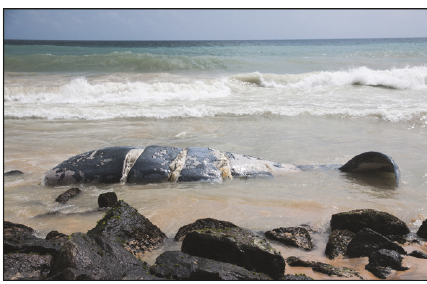
Figure 2: Posterior part of the blue whale.